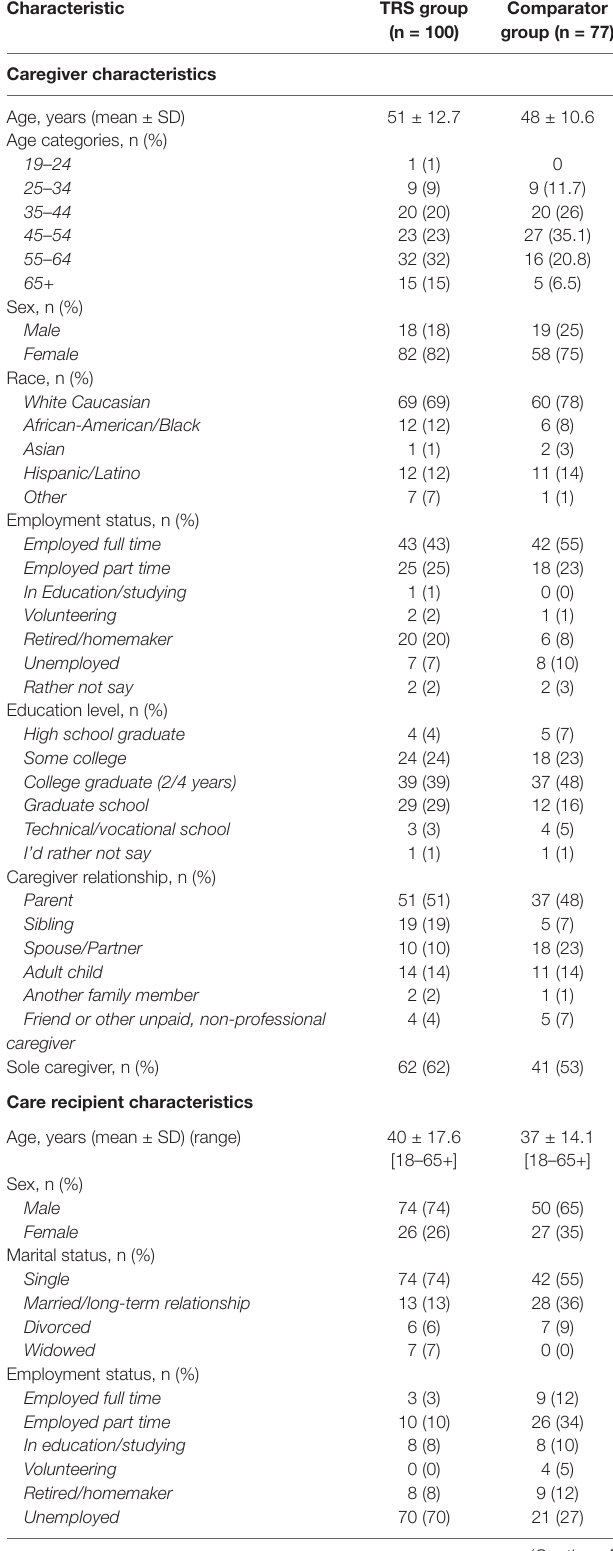
TABLE 1 | Caregiver and care recipient